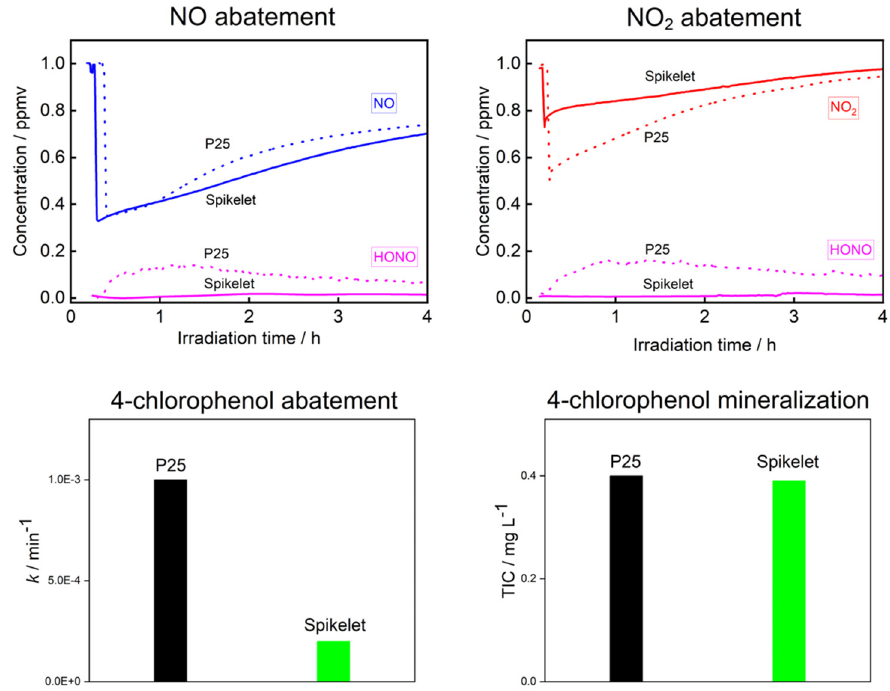
Figure 7. Photocatalytic removal of 1 ppm NO and 1 ppm NO 2 on P25 and Spikelet TiO 2 layers. Photocatalytic abatement of 4-chlorophenol and its mineralization expressed as TIC (Total Inorganic Carbon) on P25 and TiO 2 spikelet layers.